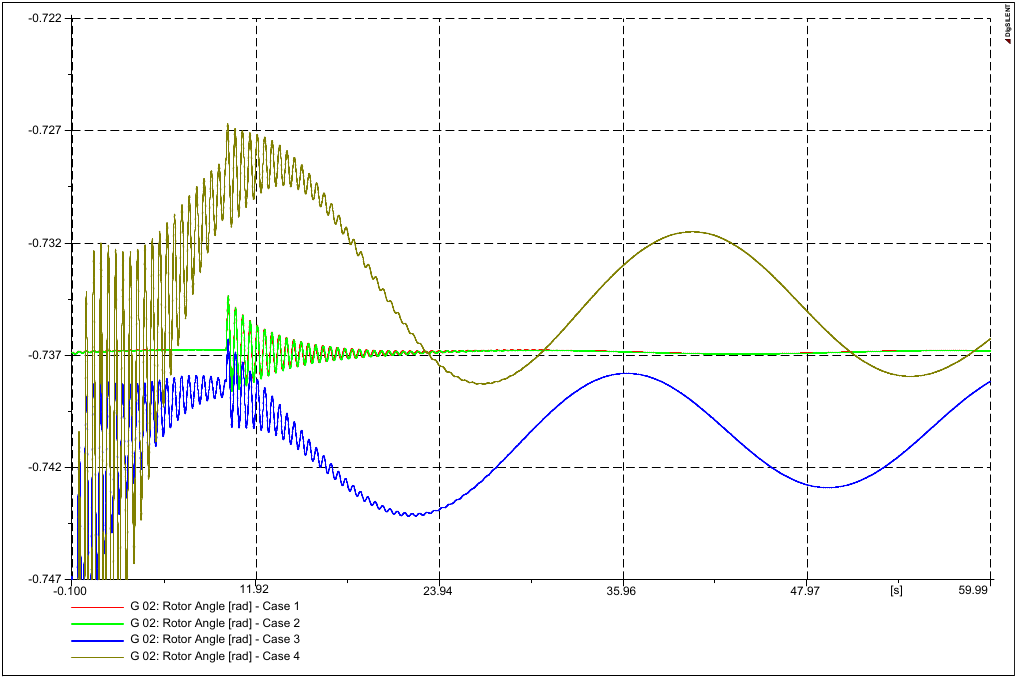
Figure 7. Angles of Machine 2 in the first scenario.